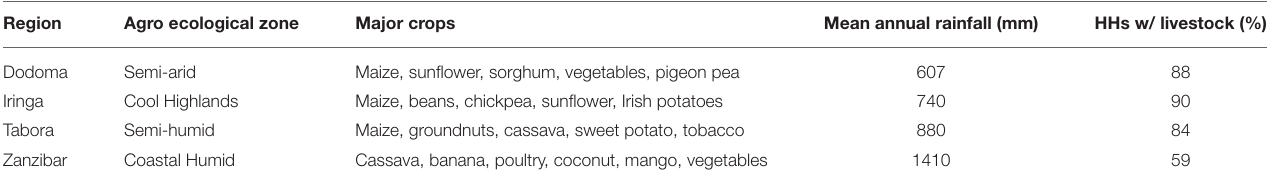
TABLE 1 | Agricultural characteristics of study regions.